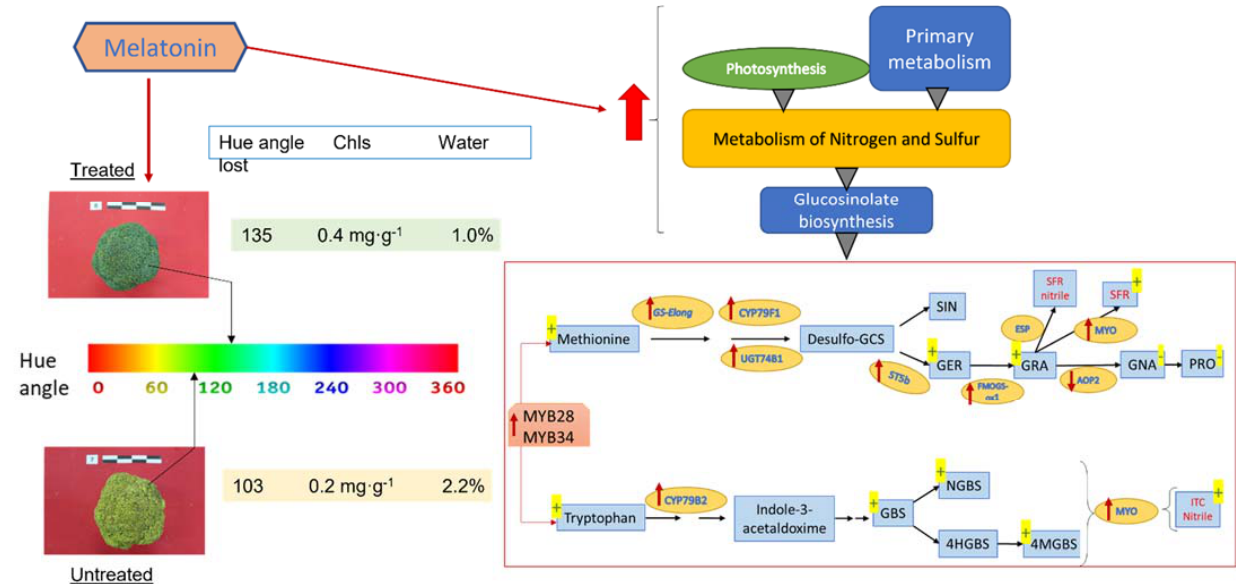
Figure 1. Representative model of melatonin’s effects on broccoli florets postharvest. Red arrows mean up-/downregulation, and yellow +/ − means higher/lower levels with respect to untreated broccoli heads.